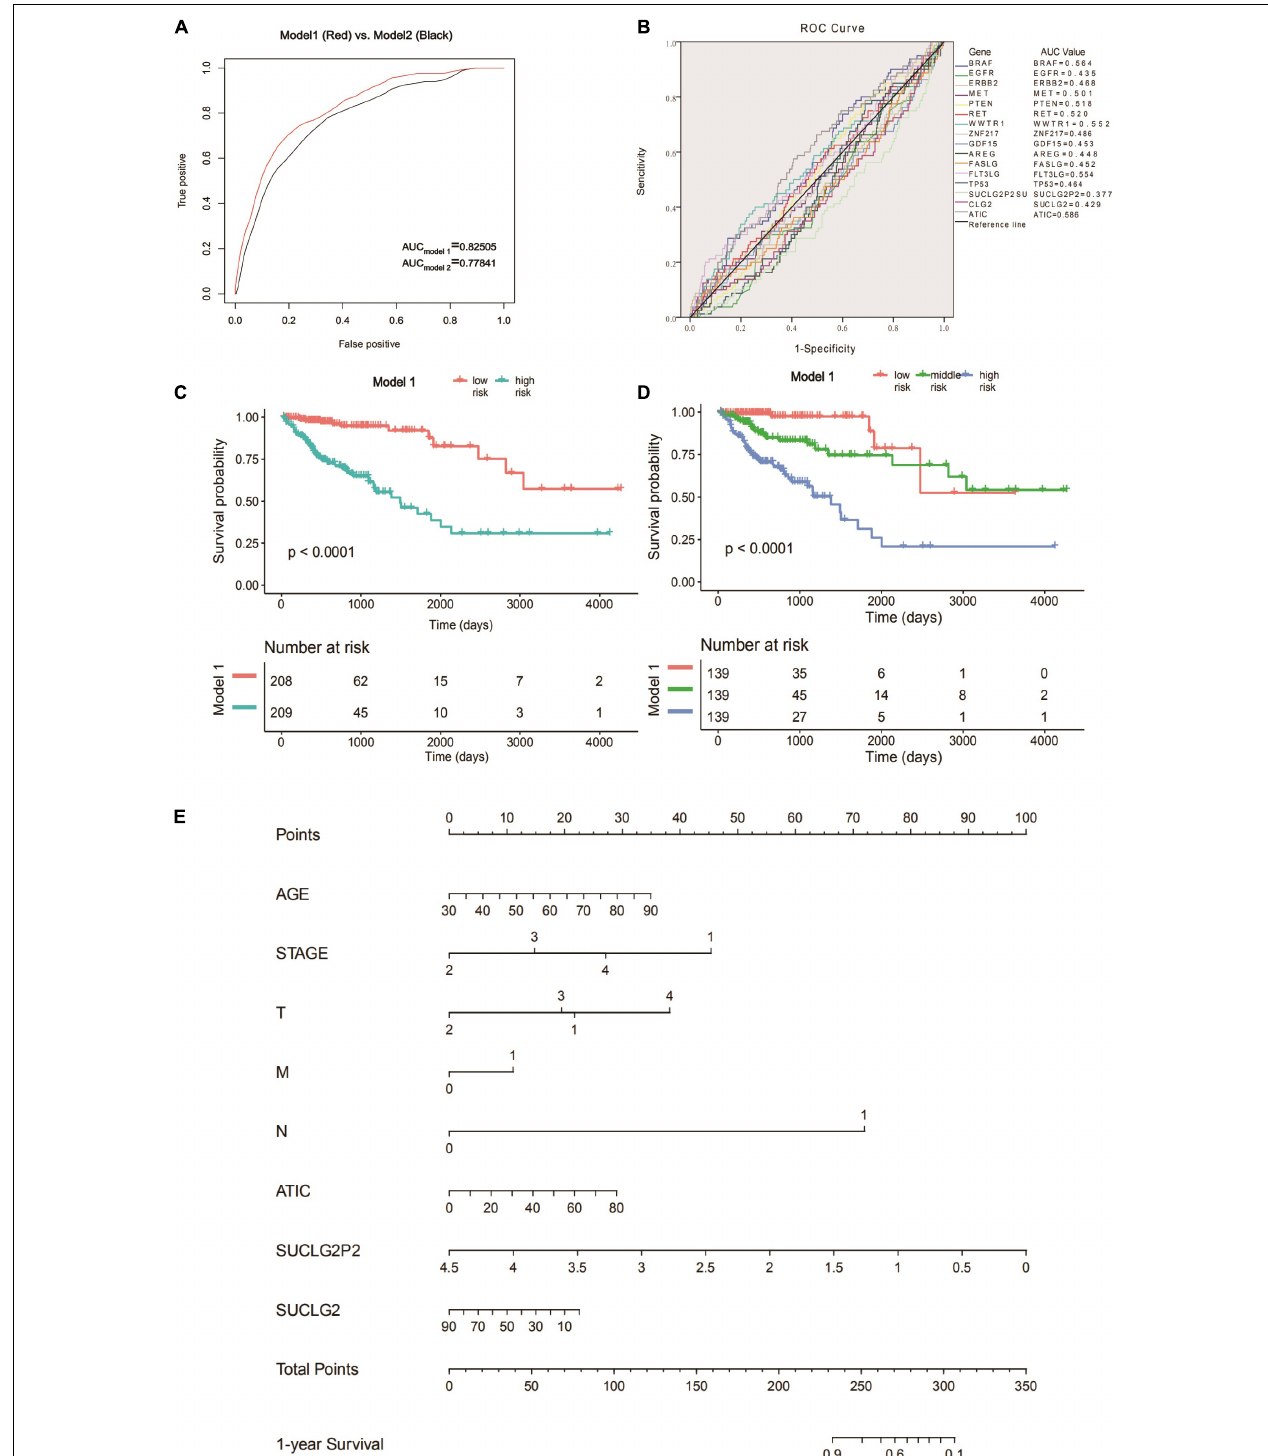
FIGURE 2 | Searching for prognostic models and construct nomogram. (A) The ROC analysis of model 1 and model 2 for survival prediction. (B) ROC curves were performed for the clinically commonly used molecular markers of colon cancer and the three screened genes. (C) Survival curve of low- and high-risk groups stratified by model 1. (D) Survival curve of low- middle -risk and high-risk groups stratified by model 1. (E) Nomogram for predicting 1-year survival for COAD patients based on model 1. ROC, receiver operating characteristic.